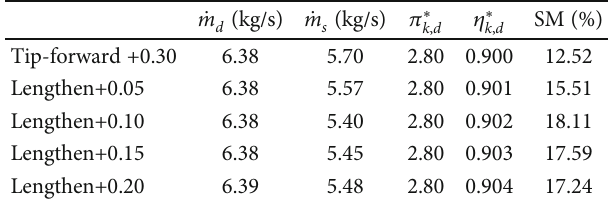
Figure 25: Mach number contours near the stall point. Table 8: Aerodynamic performance of fi ve rotors with di ff erent tip chord